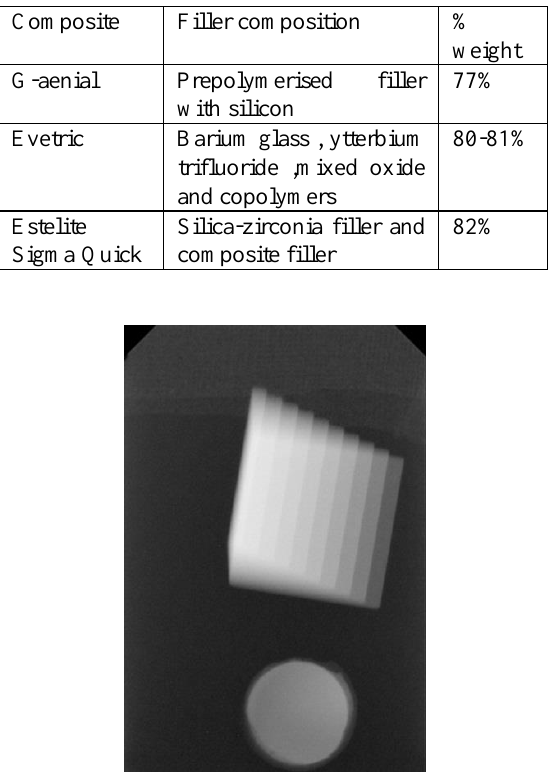
Table 1: Filler compositions taken from the